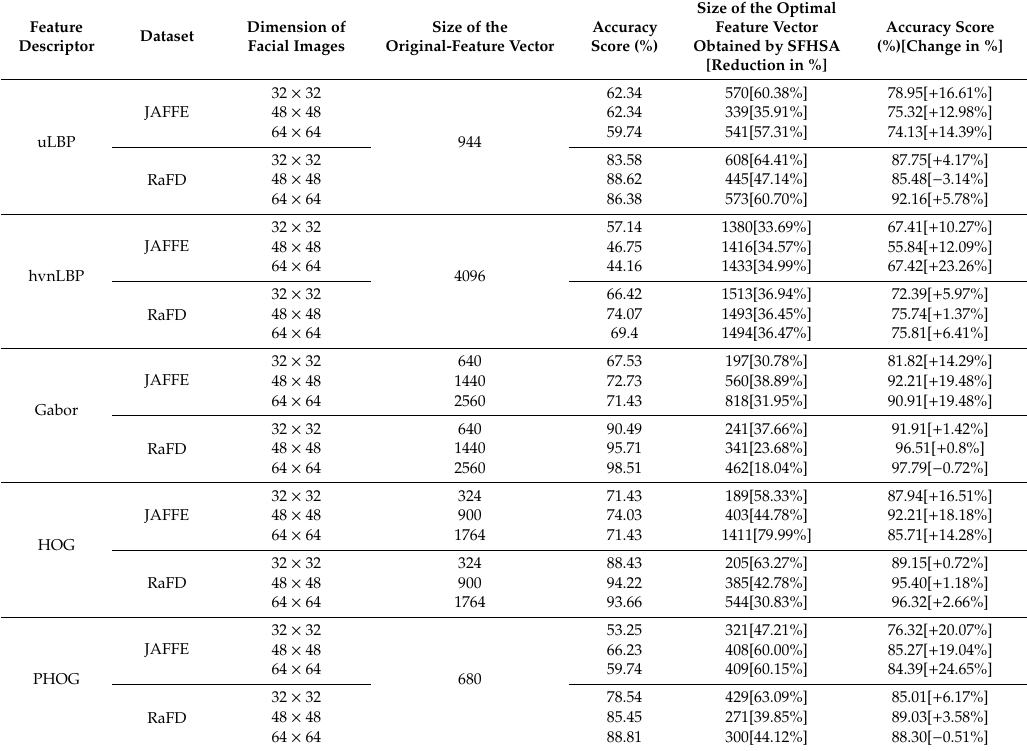
Table 2. Tabular representation of the details of original-feature size, reduced-feature size, accuracy score and their corresponding percentage of reduced-feature size with respect to original-feature size and change in accuracy score of 5 di ff erent feature vectors extracted from facial images of 3 di ff erent dimensions for two popular FER